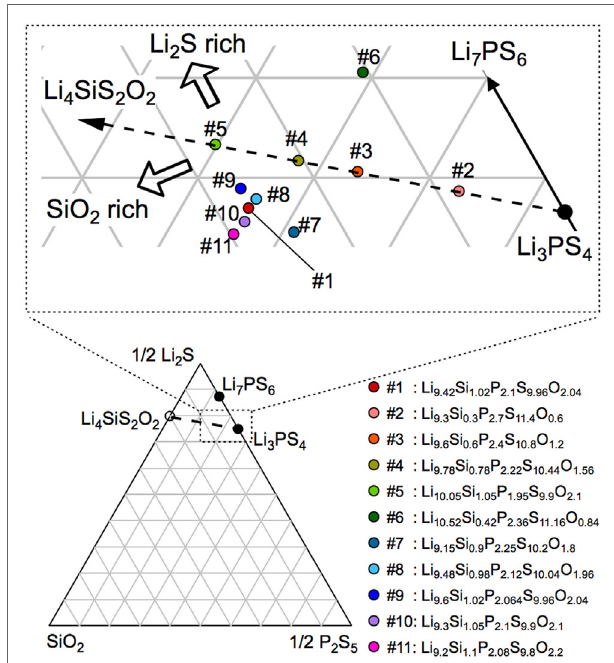
FigUre 1 | composition diagram for the li 2 s–P 2 s 5 –siO 2 pseudoternary system . The compositions synthesized in this study are indicated along with the related label numbers in the magnified view of the diagram. The compositional formulas corresponding to these label numbers are also shown on the lower right-hand